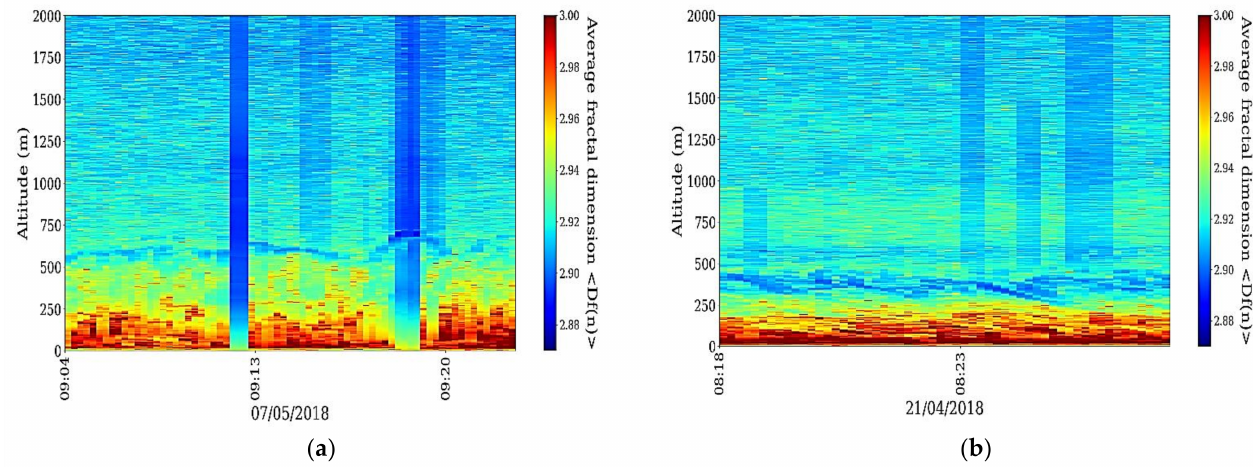
Figure 12. 〈𝐷 (cid:3007) (cid:4666)𝑛(cid:4667)〉 timeseries: ( a ) 07 May 2018, 15 s temporal resolution; ( b ) 21 April 2018, 10 s temporal resolution. Figure 12. (cid:104) D F ( n ) (cid:105) timeseries: ( a ) 07 May 2018, 15 s temporal resolution; ( b ) 21 April 2018, 10 s temporal resolution.